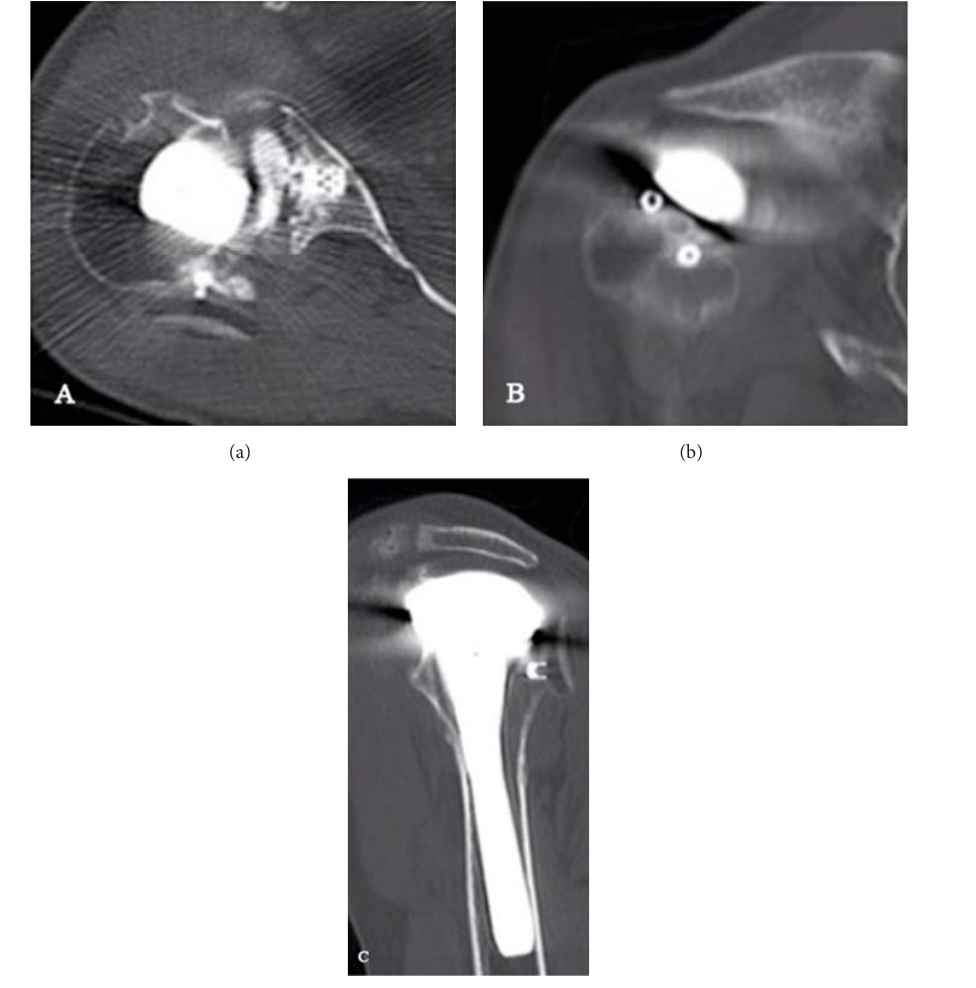
Figure 1: Selected axial (a), coronal (b), and sagittal (c) cuts of CT demonstrating dissociated glenoid component with cage remaining seated in the glenoid.